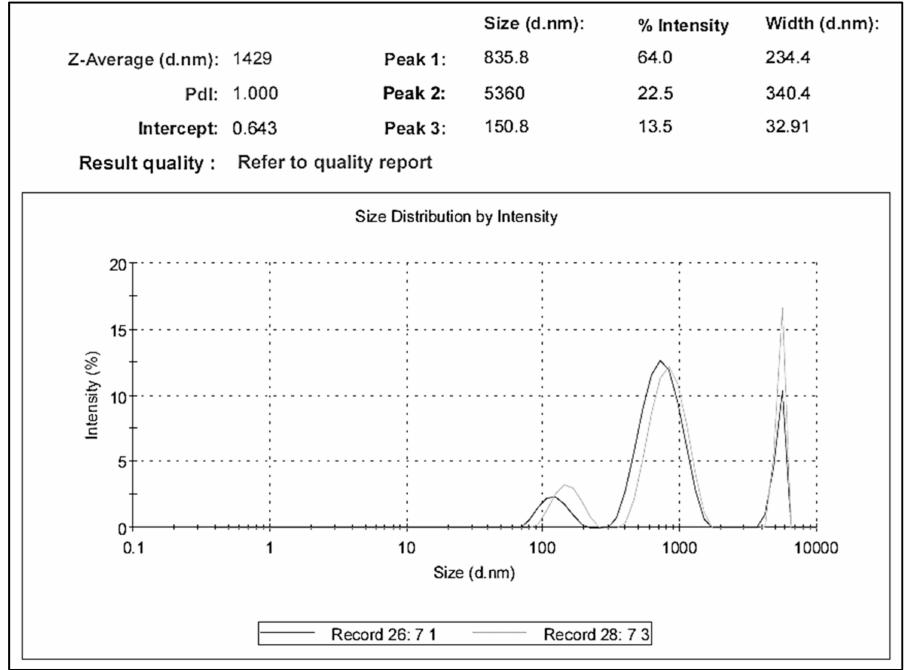
Figure 12. Dynamic Light Scattering (DLS) of P. capillacea nanoparticle